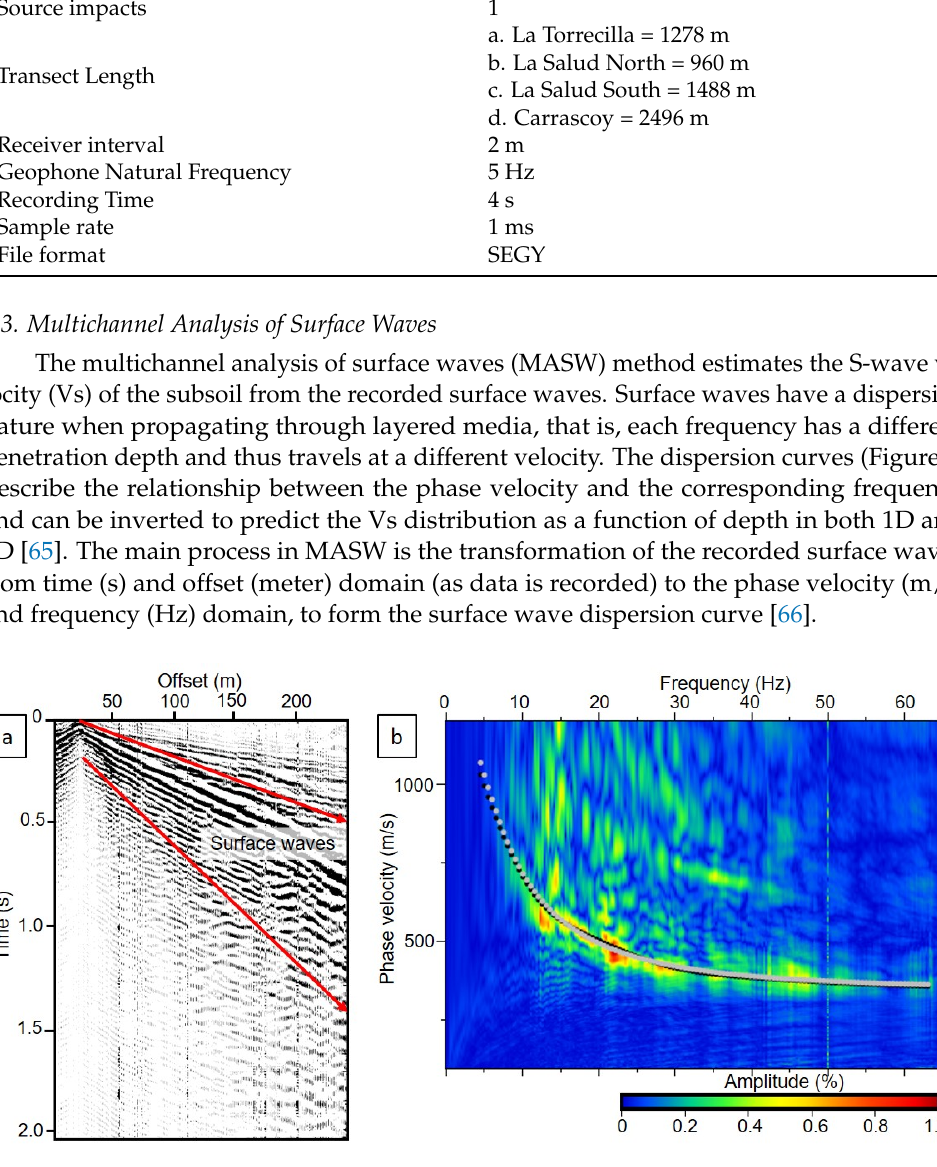
Figure 5. ( a ) Example seismic shot record with labelled red arrows showing the extent of the surface waves. ( b ) Corresponding dispersion diagram. The high amplitudes are indicative of the different phases (frequency and phase-velocity). The theoretical and inverted curves are shown as white and black dots, respectively.